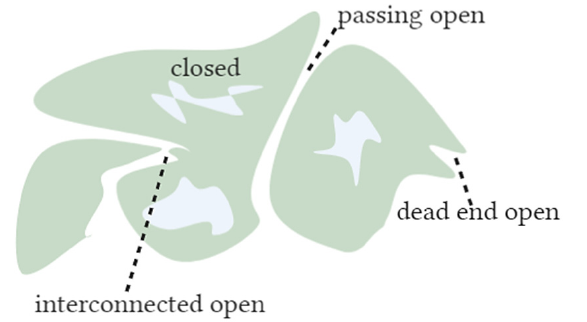
Figure 2. Pore Figure 2. Pore types.